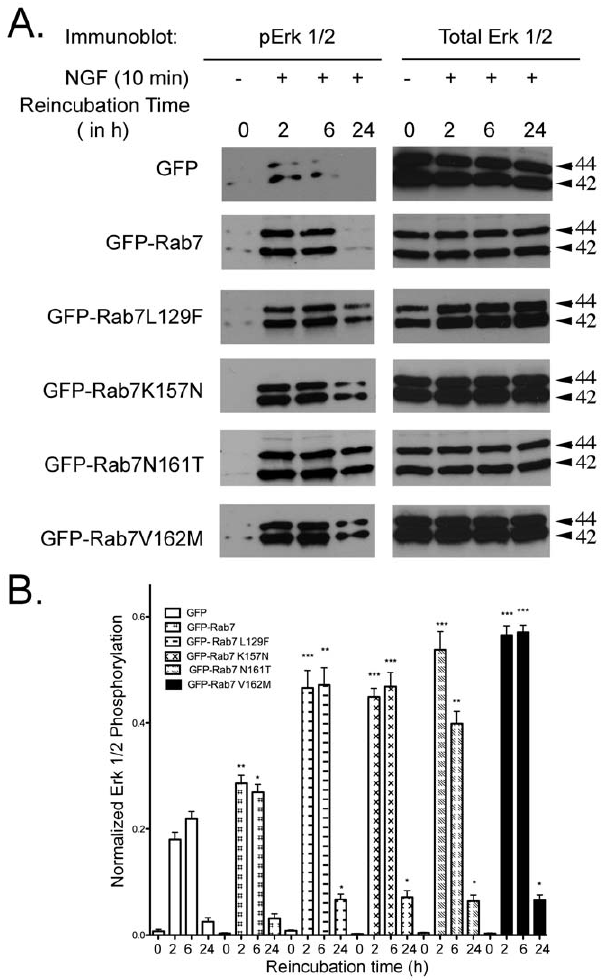
Figure 3. Cells Expressing Rab7 CMT2B Mutants Exhibit Enhanced Erk Signaling Following NGF Stimulation. (A) Tran- siently transfected PC12 cells expressing GFP, GFP-Rab7wt, GFP- Rab7L129F, GFP-Rab7K157N, GFP-Rab7N161T, GFP-Rab7 V162M were briefly stimulated with NGF (200 ng/ml) followed by surface stripping of ligand and reincubation in 0.1% BSA-DMEM for 2–24 h. Subsequently, cells were lysed and equal amounts of protein were immunoblotted and probed for total and phosphorylated Erk1/2. (B) Films from three independent experiments were quantified by Image J analysis. Bar graph shows levels of pErk1/2 in GFP-Rab7wt and CMT2B mutant expressing cells. In each case the amount of pErk1/2 was normalized to the amount of GFP protein expressed. The bar graph shows the fold- change in pErk1/2 as a function of pErk1/2 in the GFP only control at each respective time point. Error bars indicating mean 6 S.E.M., n=3,*p , 0.05; **p , 0.01, ***p , 0.001. For detailed numerical values see Table 1.